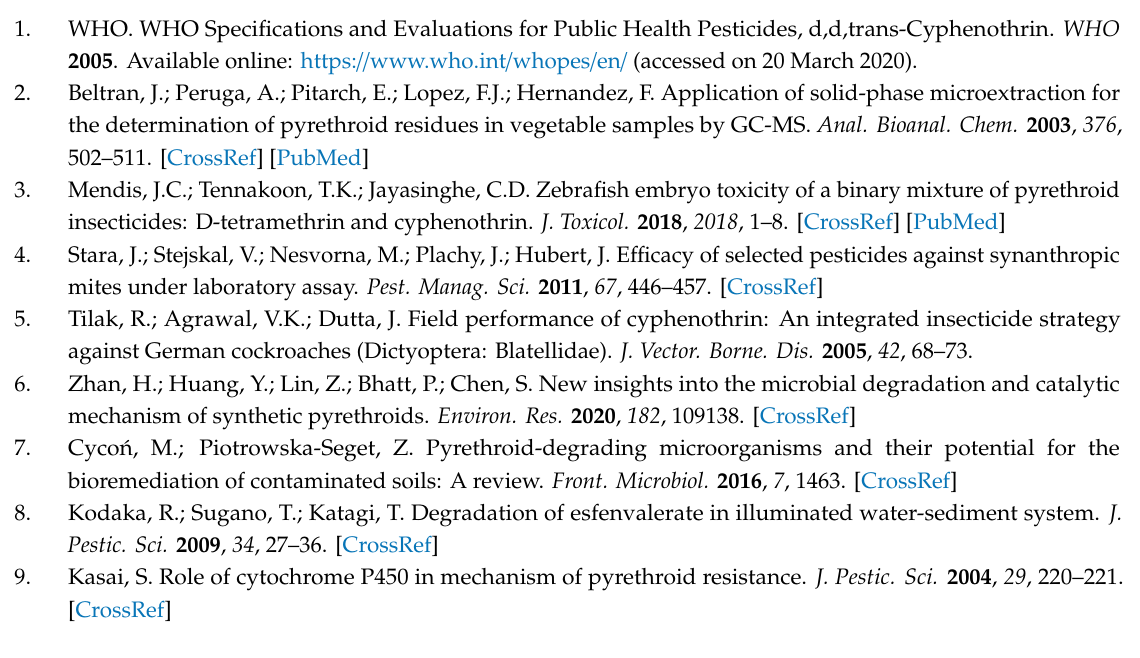
Figure S1: External morphology and scanning electron micrograph of strain HLJ-10. Pictures a (6420 × ) and b (21880 × ) are scanning electron micrographs. Picturesc and d are front and back sides of strain HLJ-10 grown on LB agar plates. Figure S2: HPLC analysis of D-cyphenothrin degradation by strain HLJ-10 over time. Figure S3: Mass spectrum of GC-MS identified for D-cyphenothrin intermediates. A1 and A2 were isomers of D-cyphenothrin, and B to G were trans -2,2-dimethyl-3-propenyl-cyclopropanol, 2,2-dimethyl-3-propenyl-cyclopropionic acid, trans -2,2- dimethyl-3-propenyl-cyclopropionaldehyde, α -hydroxy-3-phenoxy-benzeneacetonitrile, 3-phenoxybenzaldehyde, and 1,2-benzenedicarboxylic acid, dipropyl ester, respectively. Figure S4: The mass spectra of D-cyphenothrin metabolites reported in the National Institute of Standards and Technology (NIST, USA) library database. (a) trans -2,2-dimethyl-3-propenyl-cyclopropanol; (b) 2,2-dimethyl-3-propenyl-cyclopropionic acid; (c) trans -2,2-dimethyl-3-propenyl-cyclopropionaldehyde; (d) α -hydroxy-3-phenoxy-benzeneacetonitrile; (e) 3-phenoxybenzaldehyde; (f) 1,2-benzenedicarboxylic acid, dipropyl ester. Table S1: Physiological and biochemical characteristics of strain